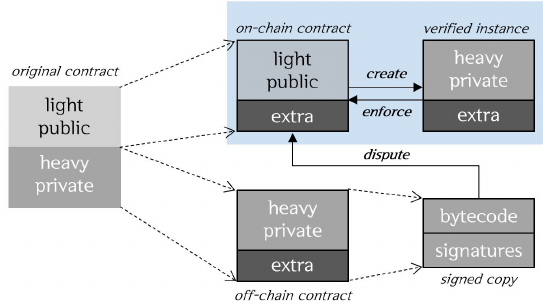
Figure 1. On/off-chain smart contracts